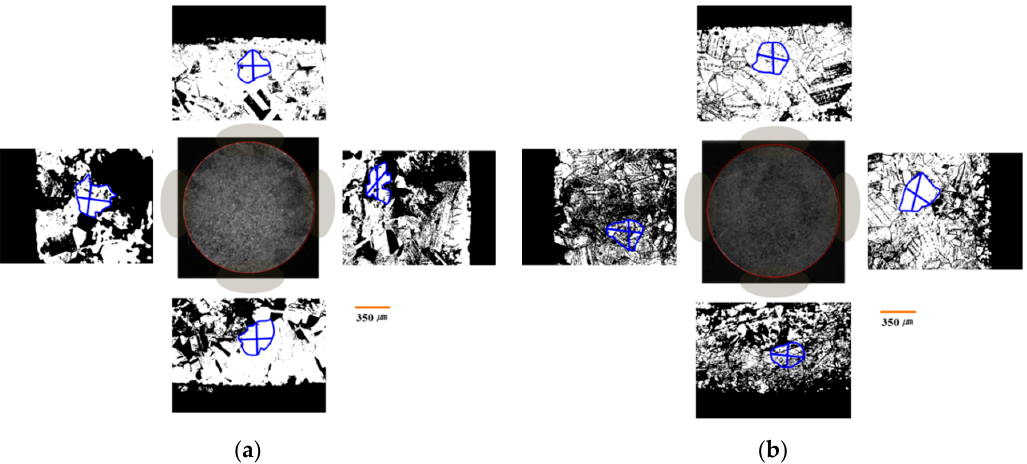
machining time 40–120 s). time 40–120 s).